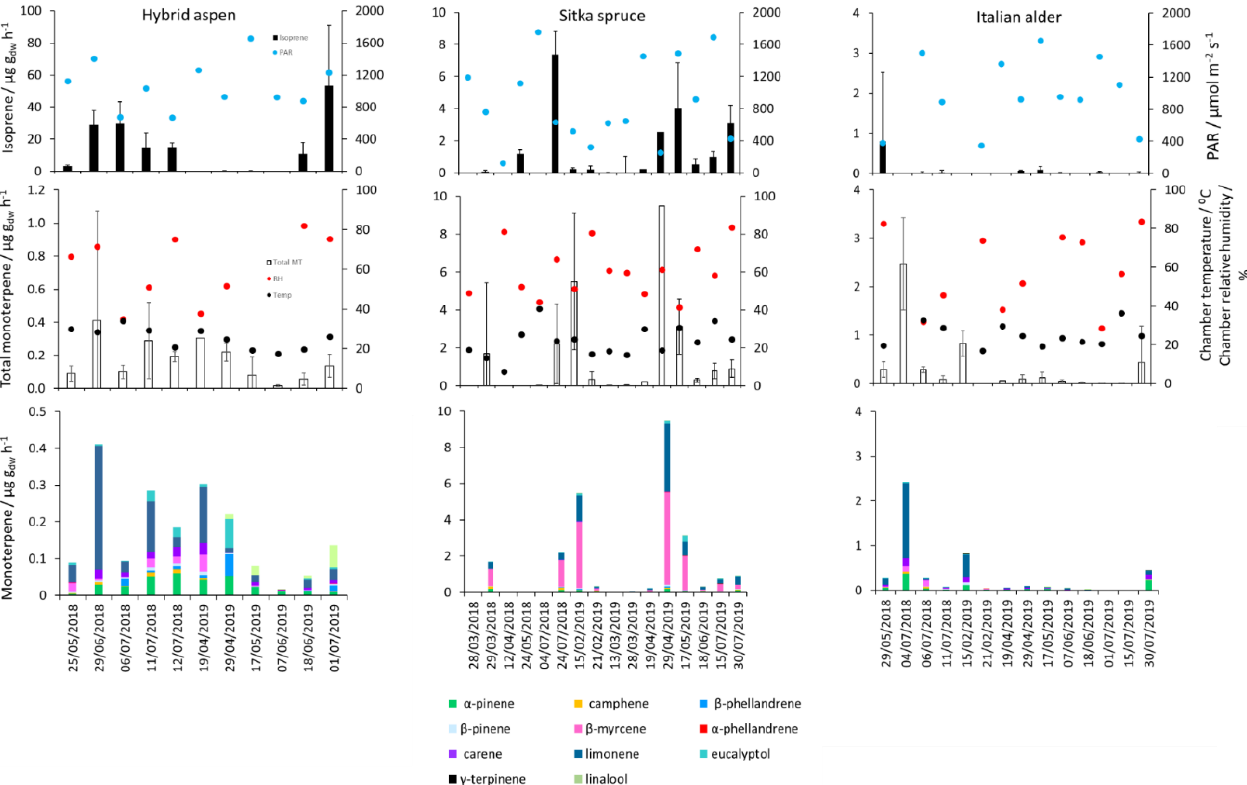
Figure 1. Mean isoprene, total monoterpene and speciated standardised monoterpene emissions from branches of hybrid aspen, Italian alder and Sitka spruce trees in SRF plantations at the East Grange site, Fife, between March 2018 and July 2019. Error bars show standard deviation of all measurements made on a given day. Blue, red and black circles show mean PAR, chamber relative humidity and temperature, respectively. Note that emission scales differ between tree species.